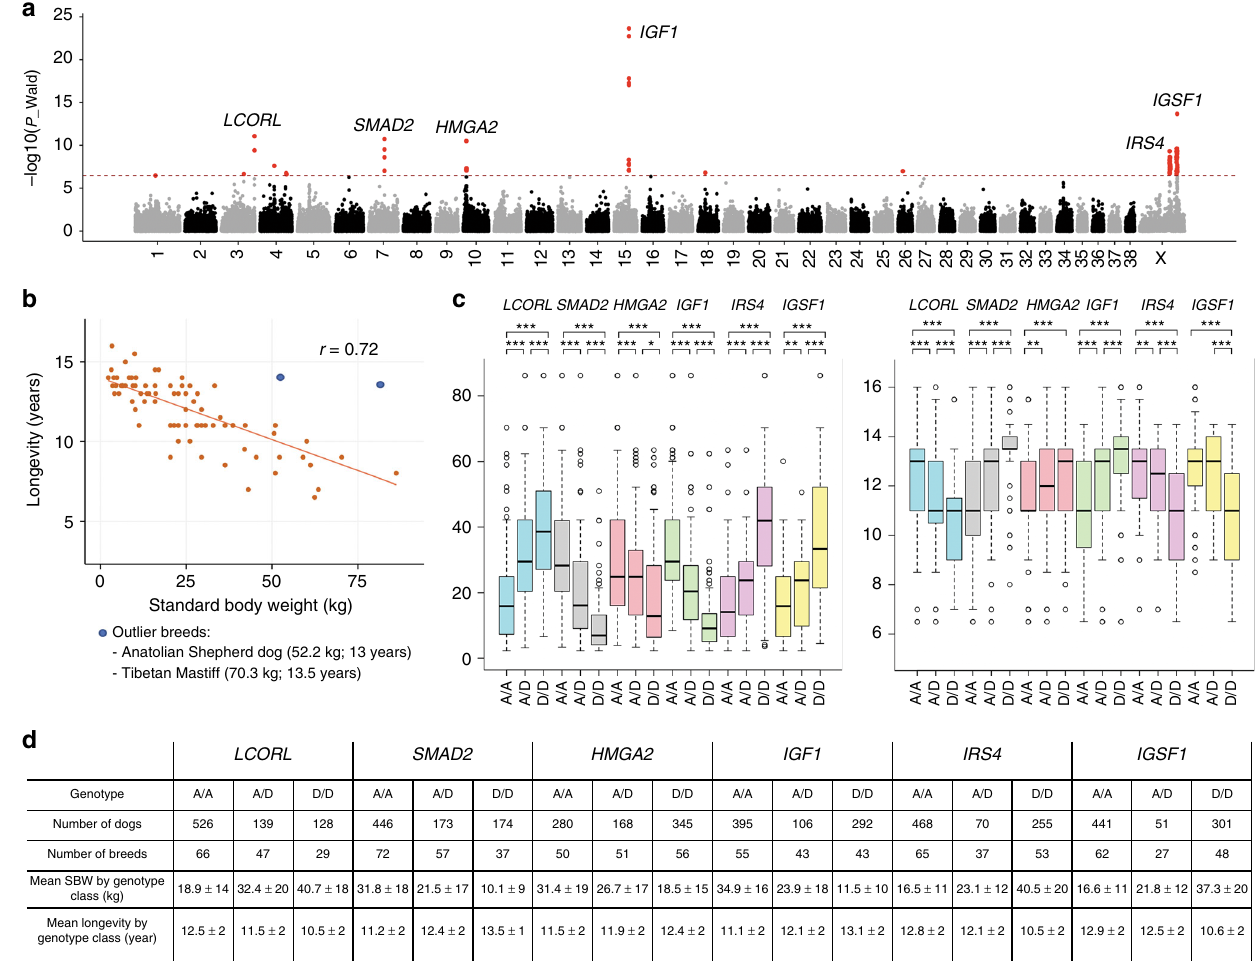
Fig. 3 Body mass and longevity analyses using 746 dogs genotyped on 170k SNP markers. a Manhattan plot of the multivariate GWAS for standard breed weight (SBW) and life span corrected by sex, using 746 dogs genotyped on Illumina HD SNP array 11 . The − log10 P values for each SNP are plotted on the y -axis versus each canine autosome and the X-chromosome on the x -axis. The red line represents the Bonferroni corrected signi fi cance threshold ( − log 10 ( P ) = 6.48) and SNPs passing this threshold are colored in red. b Negative correlation between SBW and longevity. In blue, large breed outliers: Anatolian Shepherd Dogs (52.2 kg; 13 years) and Tibetan Mastiff (70.3 kg; 13.5 years) c SBW and longevity ( y -axis) of each breed (without outliers) are plotted by genotype at each marker ( x -axis). The homozygous D/D alleles have generally a stronger effect on the distribution of SBWs (or longevity) for a given genotype/marker combination (the median and fi rst and third quartiles are indicated by the box-plots). Statistics for each